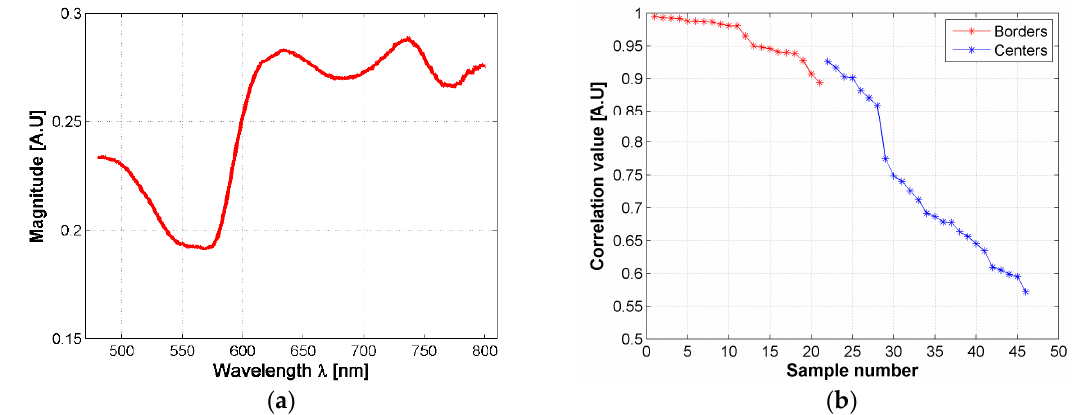
Figure 6. ( a ) mean diffuse reflectance of golden hamster’s healthy skin (reference pattern); ( b ) correlation coefficients obtained from the mean spectra of skin ulcer’s borders and centers.